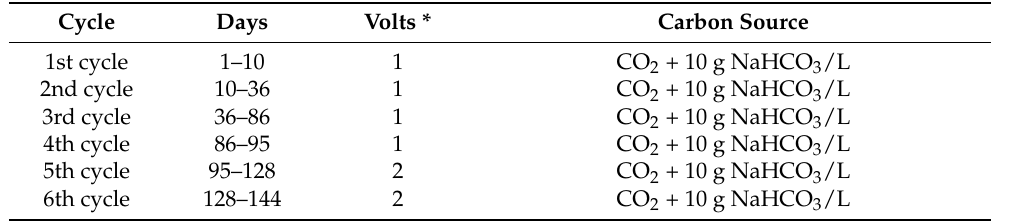
Table 2. Operational conditions and duration of each